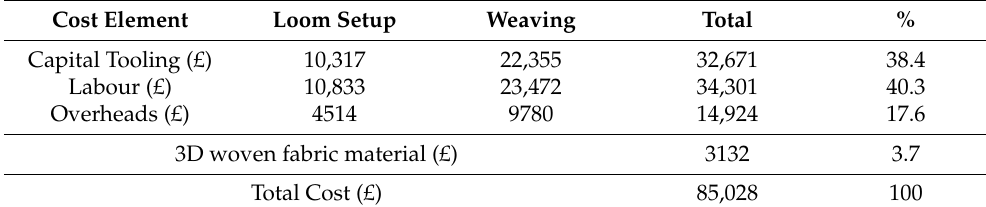
Table 9. Estimated Cost of 3D woven fabric, nineWeavebird preforms.